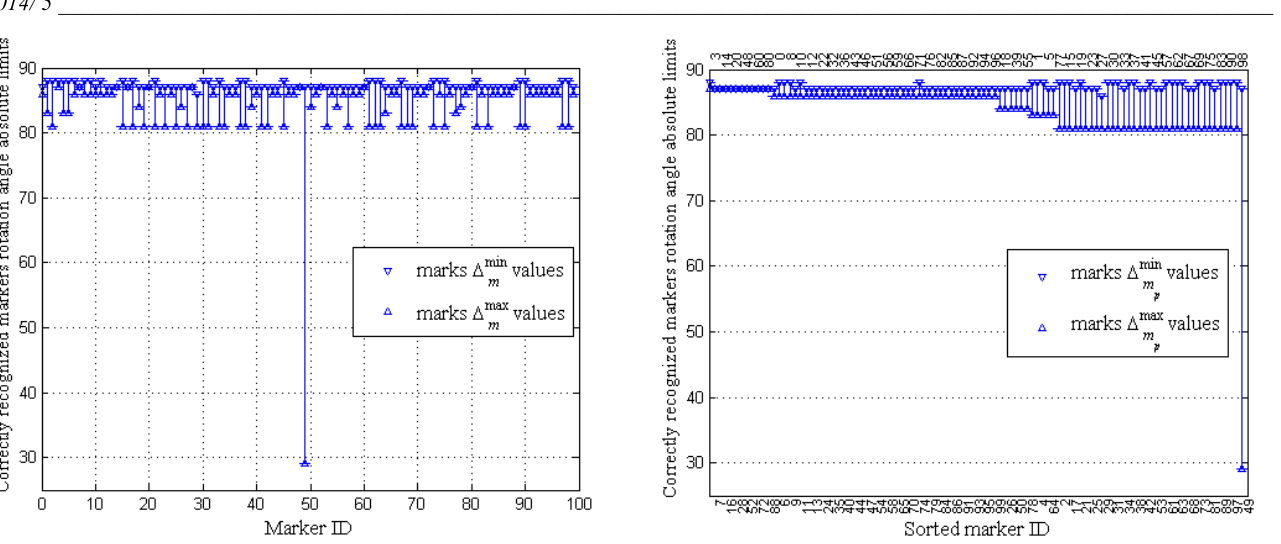
Fig. 8. Marker recognition results sorted using single criteria (4a). Note that marker IDs are shown pair wise at the bottom and the top of axis.